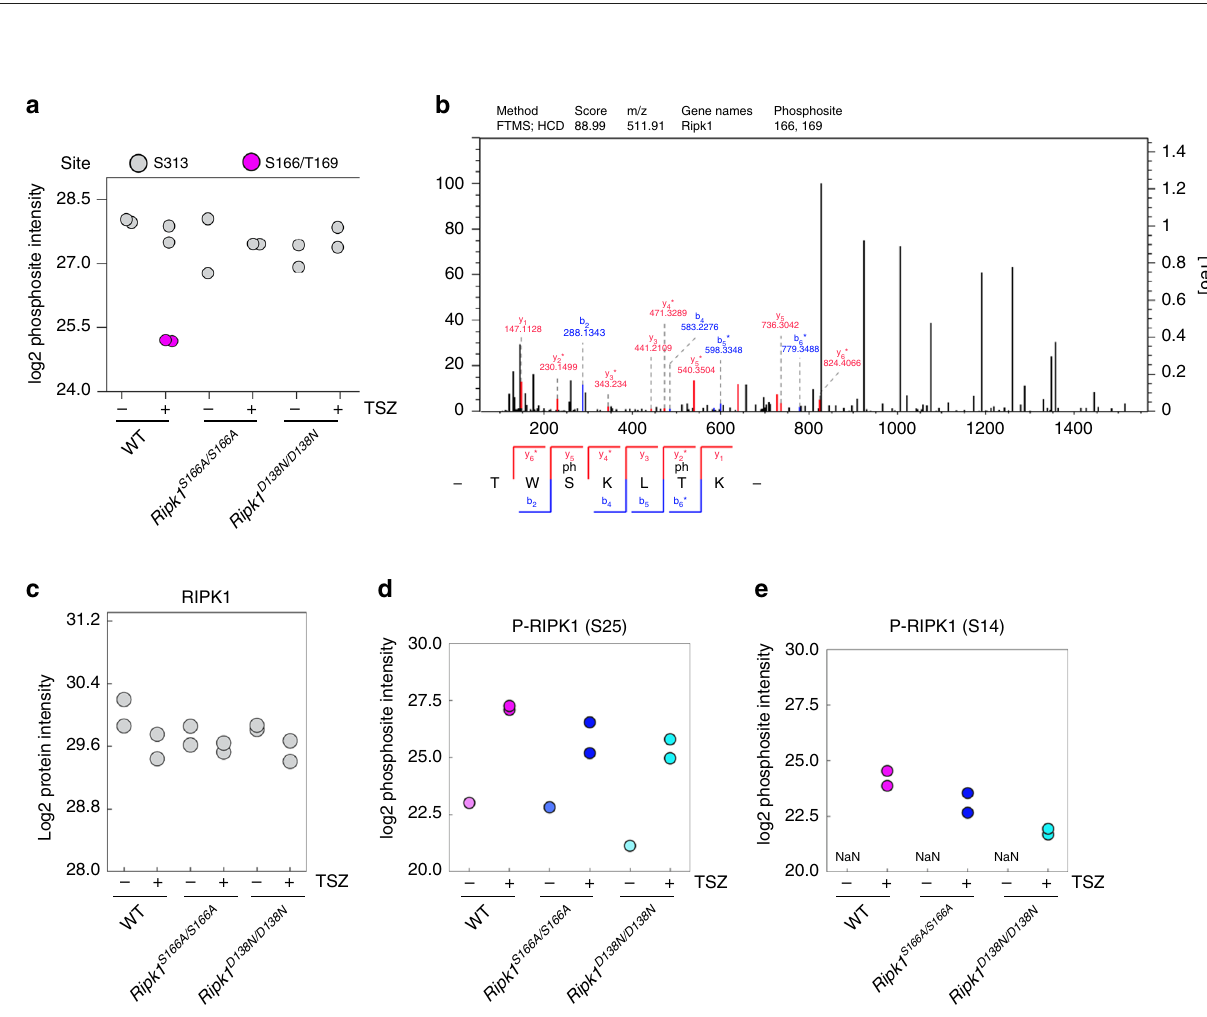
Fig. 8 S166 phosphorylation promotes RIPK1 autophosphorylation at additional sites. a LC – MS/MS measured log2 intensities of the p-S166 p-T169- and p-S313 sites after indicated treatment with or without a combination of TNF (10 ng ml − 1 ), SMAC mimetic ((Birinapant), 1 μ M) and Z-VAD-FMK (TSZ) for 2 h. b Selected LC – MS/MS scan of the p-S166/p-T169 RIPK1 peptide with annotated b-and y-ions. Fragment ions marked with asterisk (*) result from loss of the phospho-group. c LC – MS/MS measured log2 intensities of RIPK1 peptides after indicated treatment with or without a combination of TNF (10 ng ml − 1 ), SMAC mimetic ((Birinapant), 1 μ M) and Z-VAD-FMK (TSZ) for 2 h. d LC – MS/MS measured log2 intensities of the RIPK1 p-S25 site after indicated treatment with or without a combination of TNF (10 ng ml − 1 ), SMAC mimetic ((Birinapant), 1 μ M) and Z-VAD-FMK (TSZ) for 2 h. e LC – MS/MS measured log2 intensities of the RIPK1 p-S14 site after indicated treatment with or without a combination of TNF (10 ng ml − 1 ), SMAC mimetic ((Birinapant), 1 μ M) and Z-VAD-FMK (TSZ) for 2 h. a , c – e , Values from two independent experiments are shown. Histopathological scoring . Histopathological evaluation of colon tissue sections Nuclei were stained by DAPI (VectorLabs). Stainings were visualized with ABC Kit was performed on 3 µm H&E stained intestinal tissue sections in a blinded fashion Vectastain Elite (Vector Laboratories) and DAB substrate (Dako and Vector as described previously 57 . In brief, in fl ammation was assessed by the presence and Laboratories) or Alexa-488 (A1101, Molecular Probes) and Alexa-549 (A11012, Molecular Probes)- fl uorescence-conjugated secondary antibodies. F4/80 staining the localization of in fl ammatory immune cell in fi ltrates (0: absent, 1: mucosal, 2: was done on cryo sections. submucosal, 3: transmural extending into muscularis and serosa, and 4: diffuse). NATURE COMMUNICATIONS| (2020) 11:1747